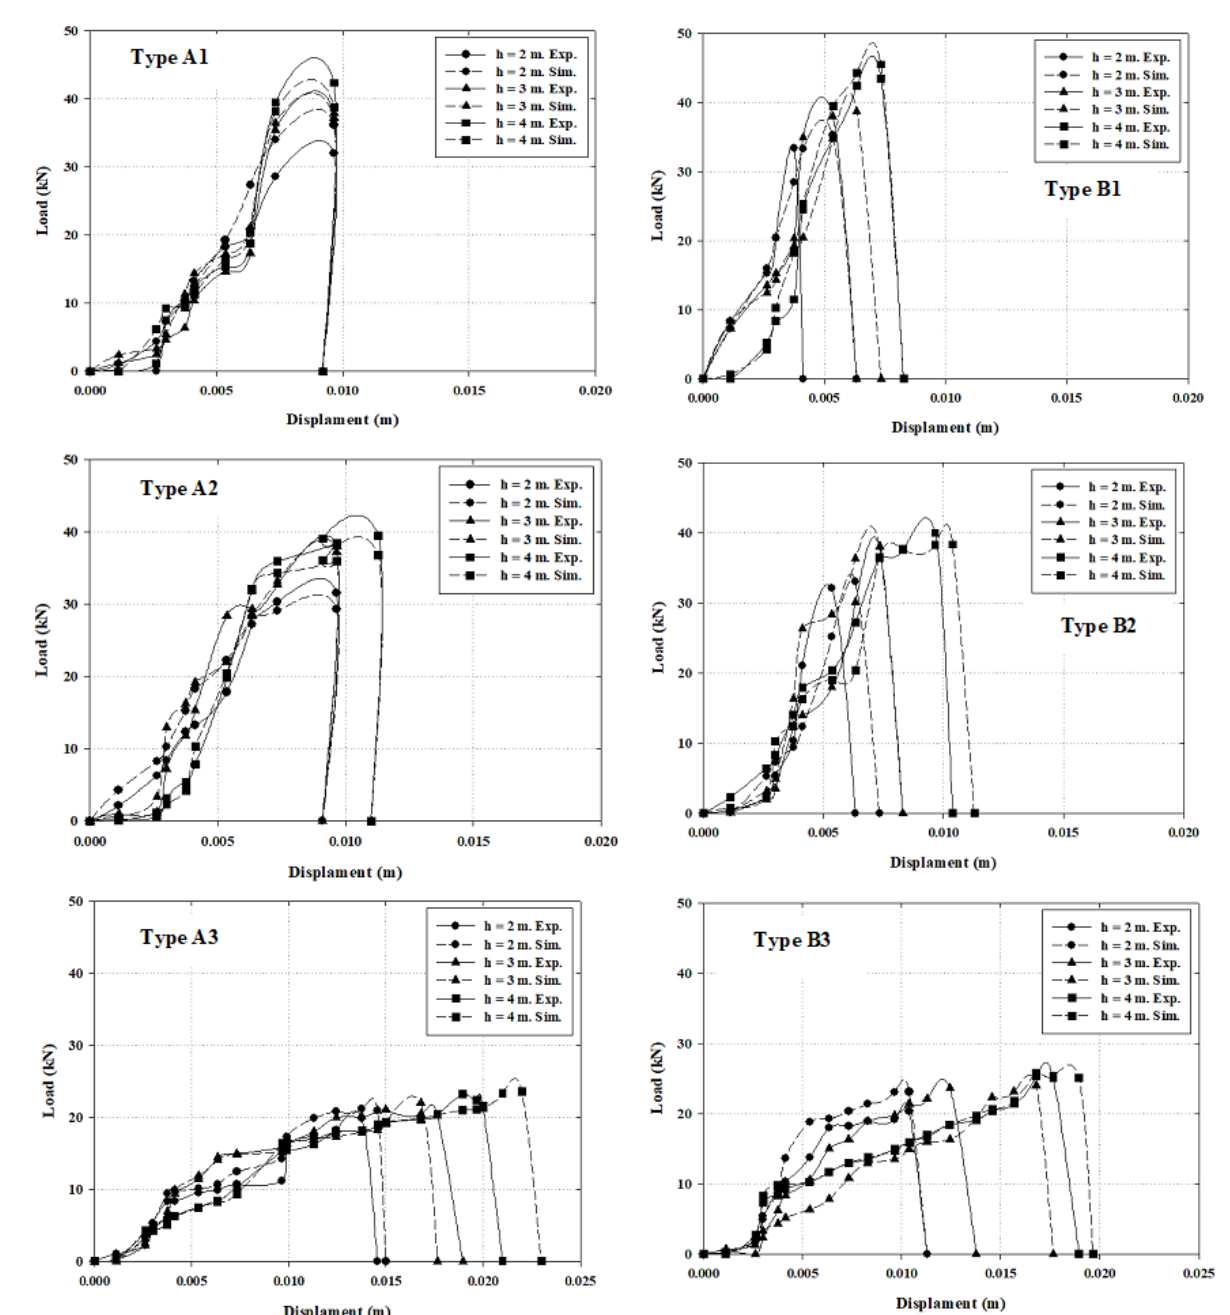
Figure 10: Comparative results between the collapse displacement and load of Type A and Type B